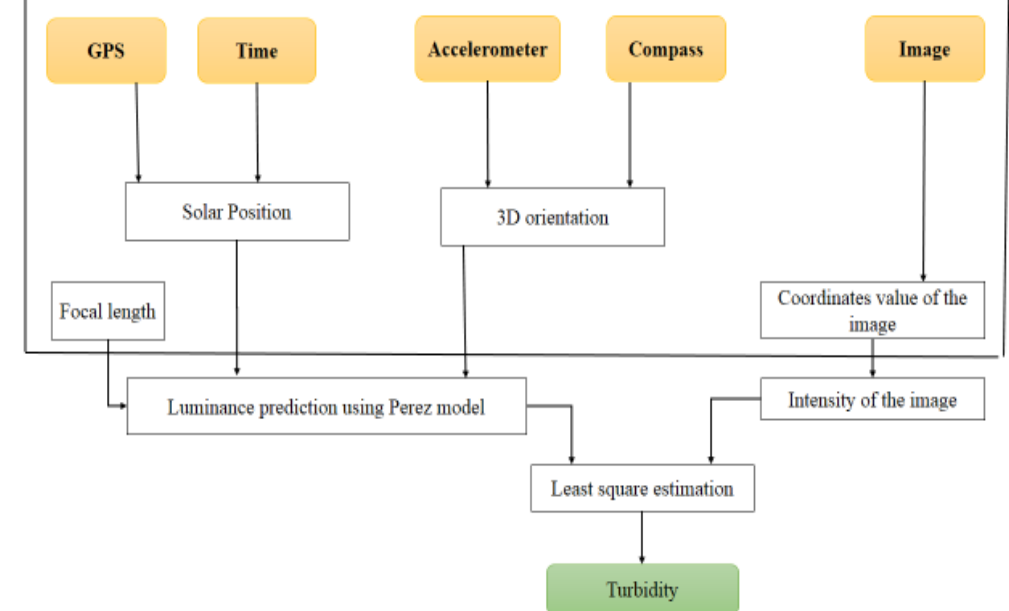
Figure 1: Theoretical framework of proposed